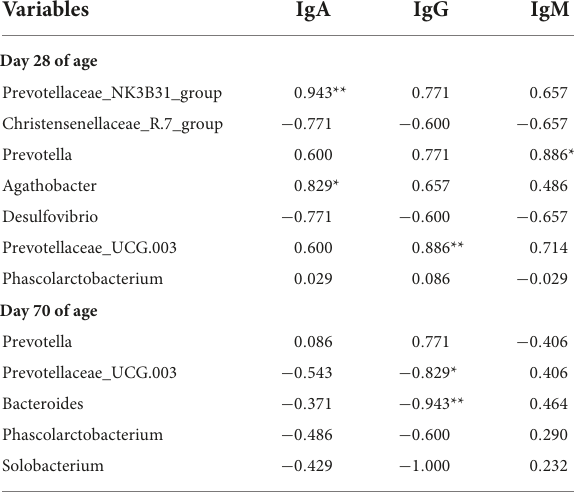
TABLE 5 Spearman’s correlations analysis between fecal microbiota and serum immunoglobulin